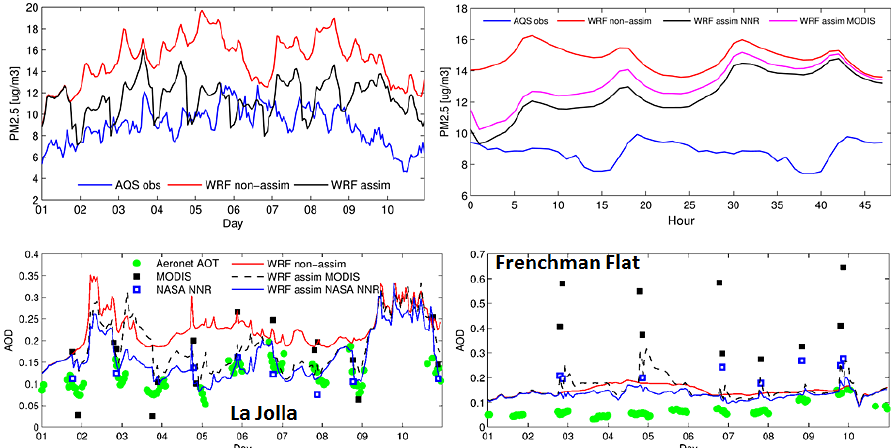
Figure 6. Results when assimilating satellite retrieved AOD over the southwestern US for the first 10 days of May 2010. Top-left panel shows time series of model and observed mean PM 2 . 5 over AQS sites in California and Nevada. Top-right panel shows mean PM 2 . 5 as a function of forecast hour for the same sites. Bottom panels show AOD time series at two sites for AERONET data (500nm), operational MODIS (550nm), NASA NNR (550nm), the non-assimilated forecast and the two assimilation forecasts (500nm). Modified from Saide et al. (2013).